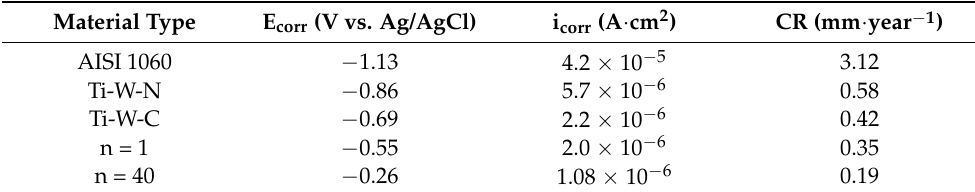
Table 3. Electrochemical parameters of the potentiodynamic curves of the monolayers, n = 1 and n = 40